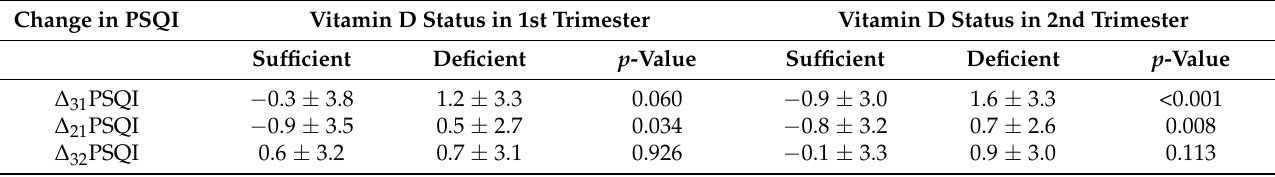
Table 4. Vitamin D and changes in sleep